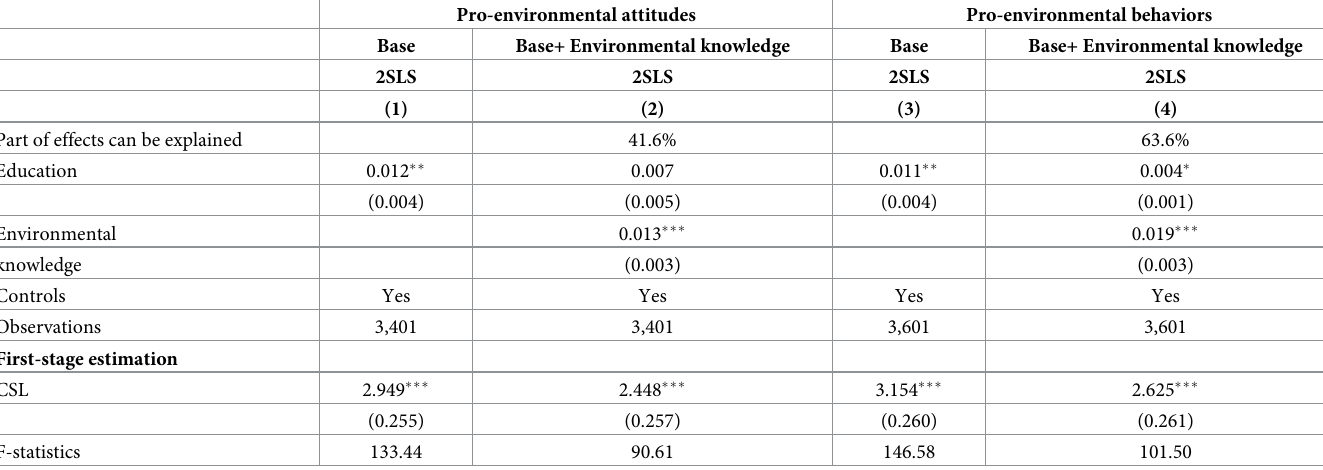
Table 9. The part of education effects mediated by environmental